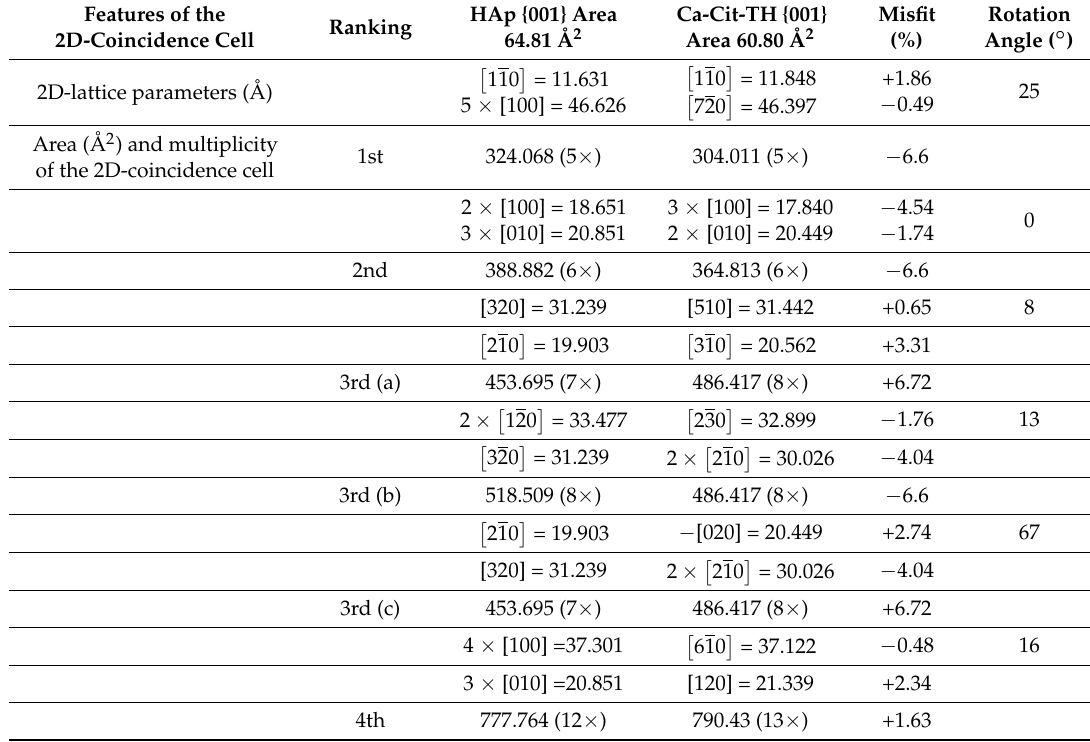
Table 1. 2D-coincidence lattices between the {001} form of HAp and the {001} form of Ca-Cit-TH. Rotation angle refers to the angle formed between the vectors [100] of both the involved 2D cells. Features of the 2D-Coincidence